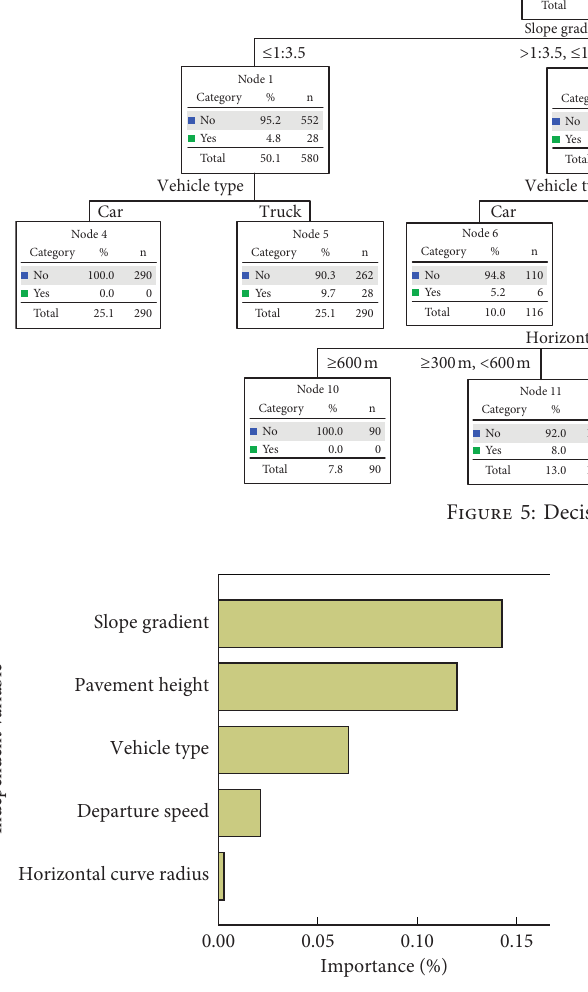
Figure 6: Importance of each test